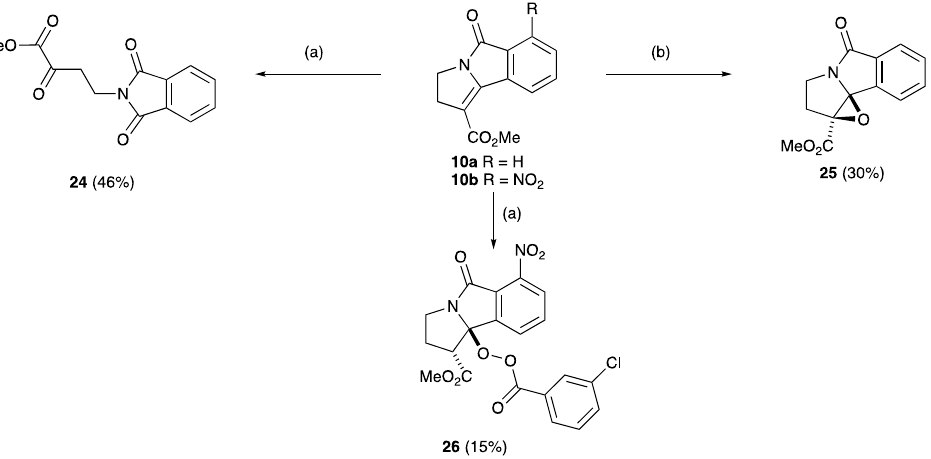
Scheme 6. Elaboration of 2,3-dihydro-5 H -pyrrolo[2,1- a